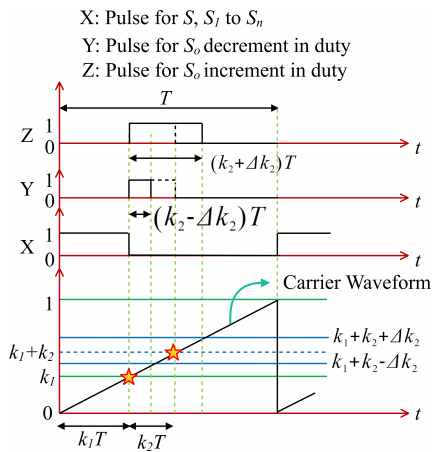
Figure 12. Control scheme-1, (X: gate pulse for switches S , S 1 − S n , Y: variation in the duty cycle of switch S o when voltage is increased at the input side, Z: variation in the duty cycle of switch S o when voltage is decreased at the input